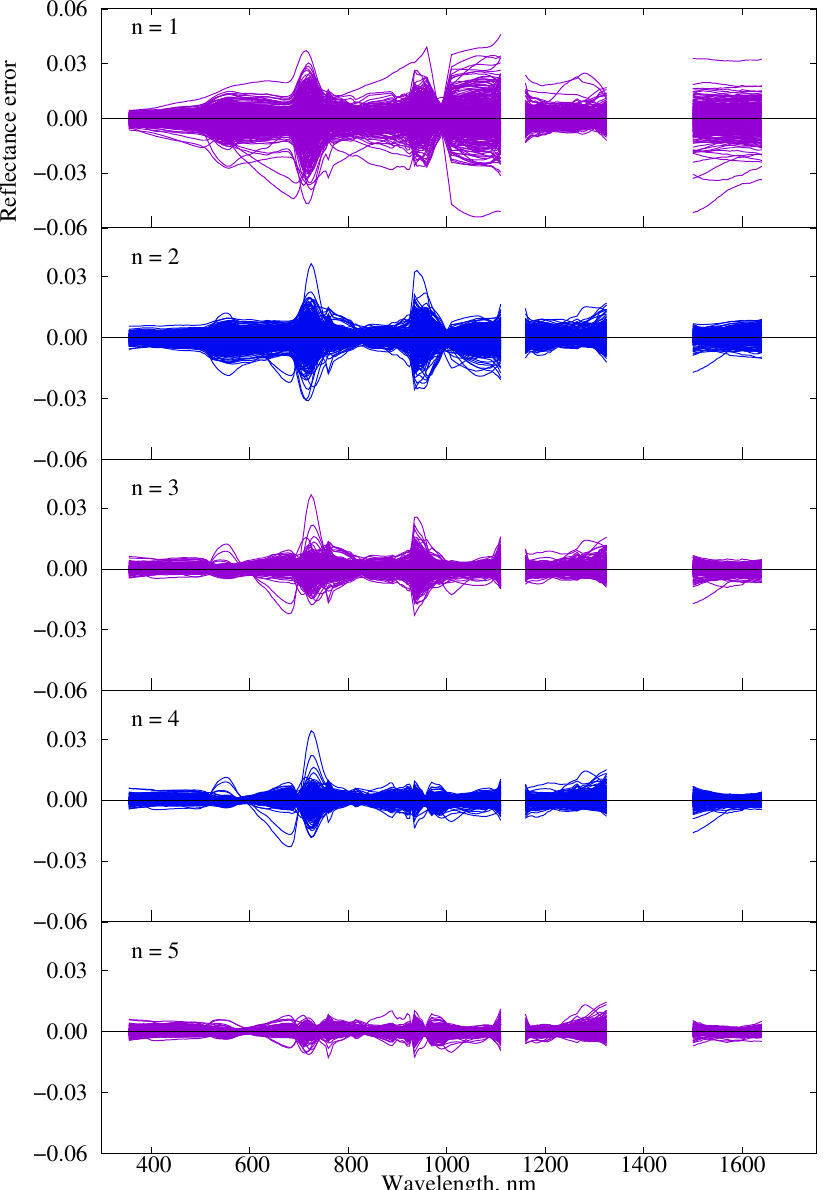
Figure 5. Error of the representation of forest spectra as a function of the number n of basis functions in Equation